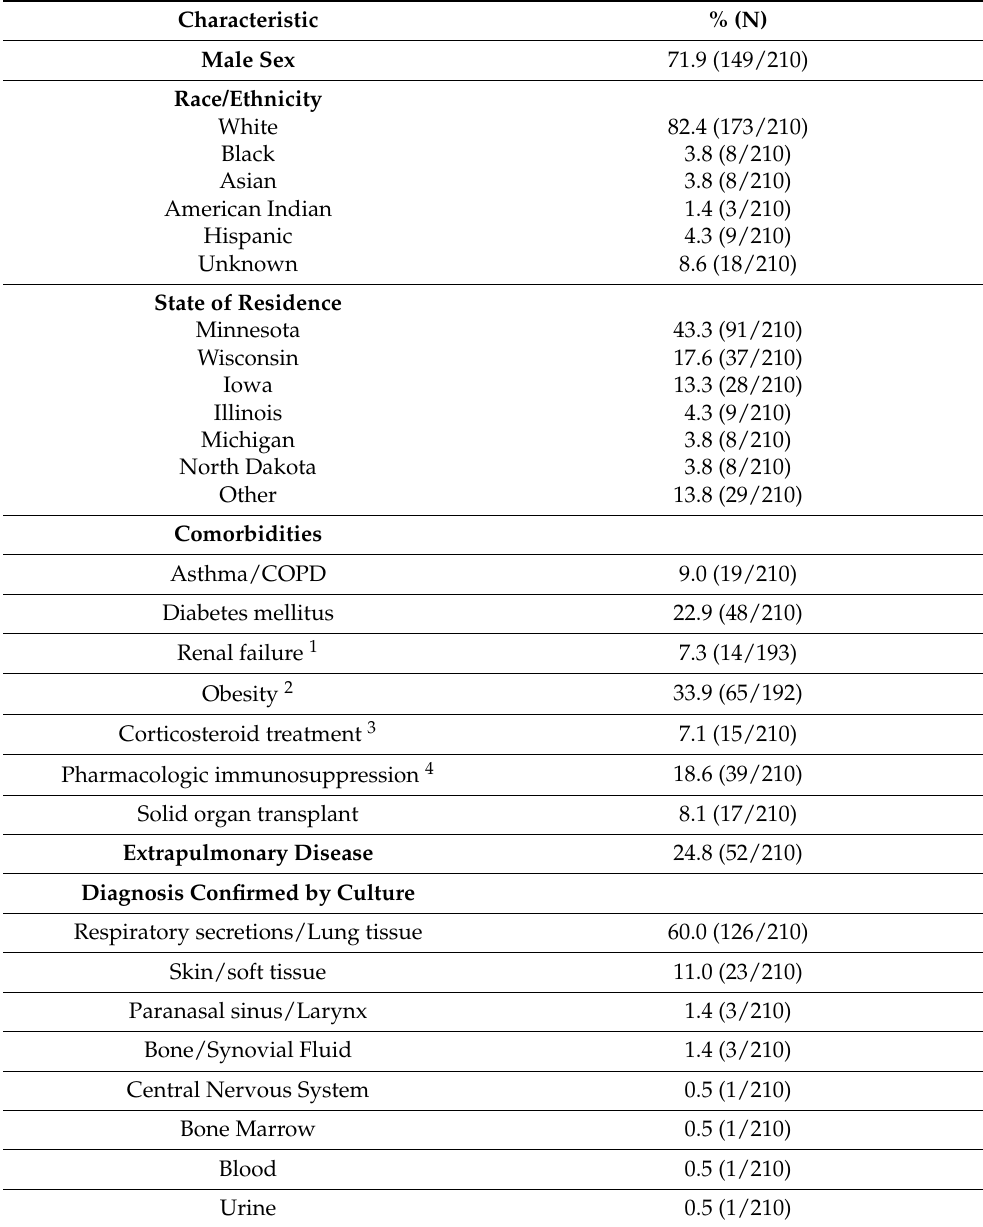
Table 1. Epidemiologic and clinical characteristics of the cohort (n =